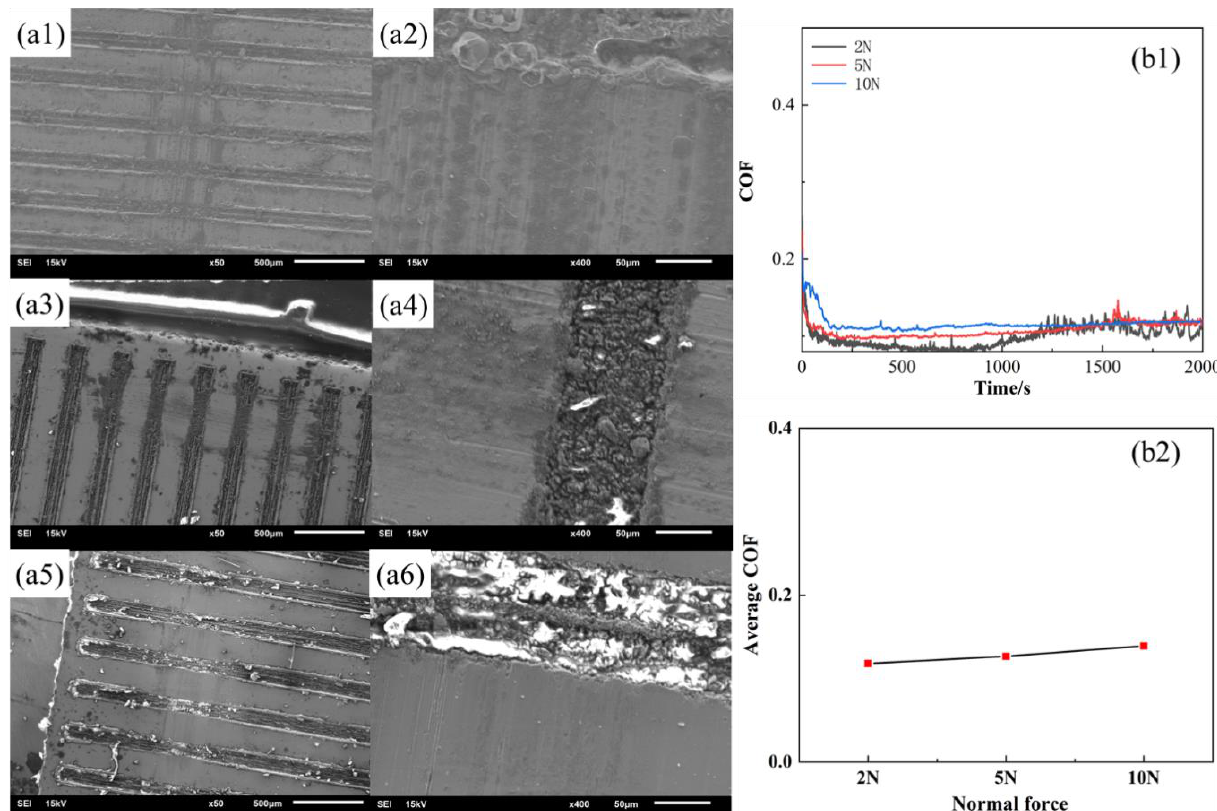
Figure 15. Morphology of Fe-Zn samples ( a1 ) T0.3-W0.1-C0.3-2N, ( a2 ) Enlarged view of a1, ( a3 ) T0.3-W0.1-C0.3-5N, ( a4 ) Enlarged view of a3, ( a5 ) T0.3-W0.1-C0.3-10N, ( a6 ) Enlarged view of a5; ( b1 , b2 ) Coefficient of friction of samples.